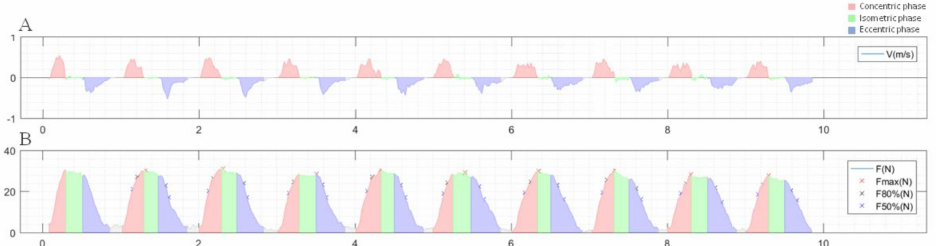
Figure 2. Graph of the information processed by MATLAB for a series of 90 ◦ shoulder slow abduction: ( A ) identification of the phases according to the velocity: red (positive) for the concentric phase, green (close to 0 m/s) for the isometric phase, and blue (negative) for the eccentric phase; ( B ) parameters of force by repetition and movement phases (example of slow shoulder